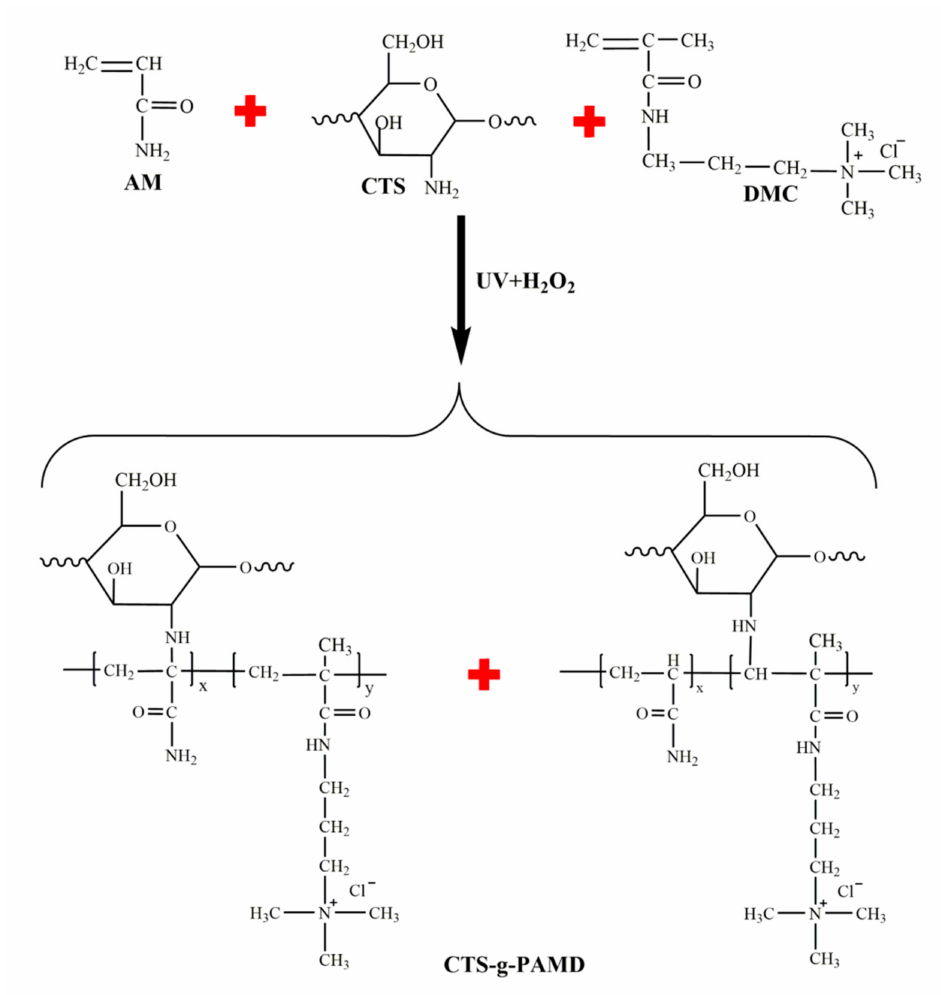
Figure 1. The reaction route of microwave assisted initiation of